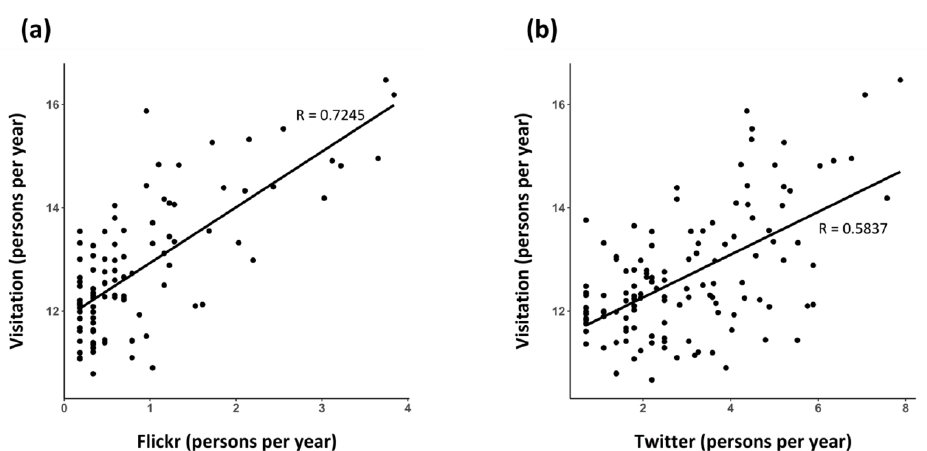
Figure 3. Correlation ( a ) between Flickr and visitation data (R = 0.7245, p < 0.001) and ( b ) between Twitter and visitation data (R = 0.5837, p < 0.001).